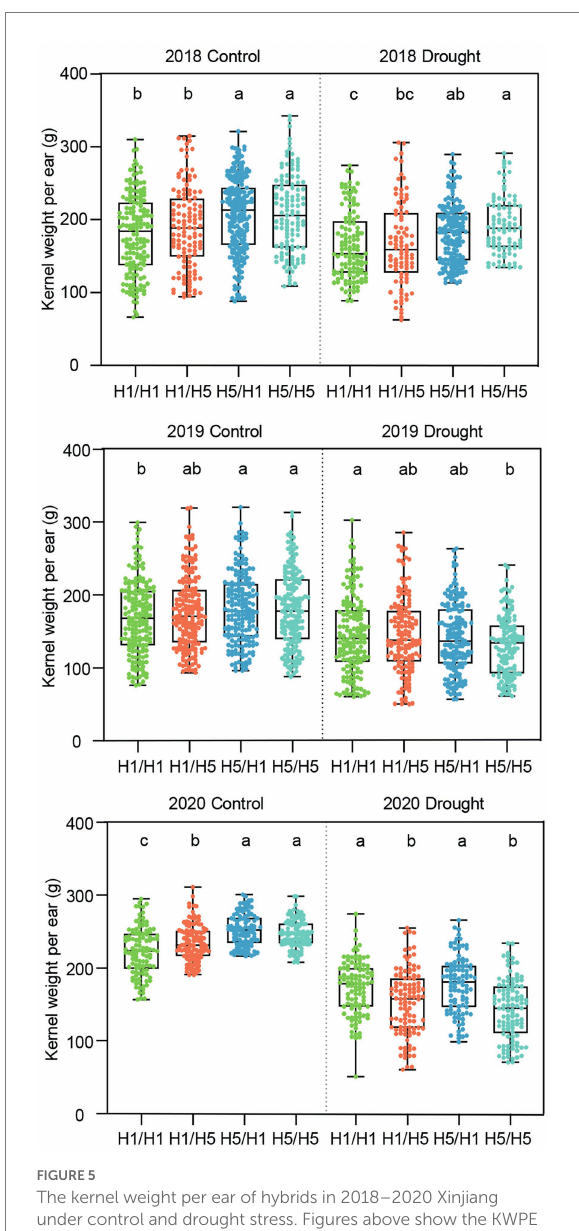
FIGURE 5 The kernel weight per ear of hybrids in 2018–2020 Xinjiang under control and drought stress. Figures above show the KWPE of hybrids in 2018, 2019, and 2020, respectively. H1/H1, H1/H5, H5/H1, and H5/H5 are genotypes of four hybrids represent 83B28 H1 × A5302 H1 , 83B28 H1 × A5302 H5 , 83B28 H5 × A5302 H1 , and 83B28 H5 × A5302 H5 , respectively. Boxes show mean and quartile, whiskers represent max to min. Different letters indicate significant differences among hybrids ( p < 0.05, one-way ANOVA, Duncan’s test, and Tamhane’s